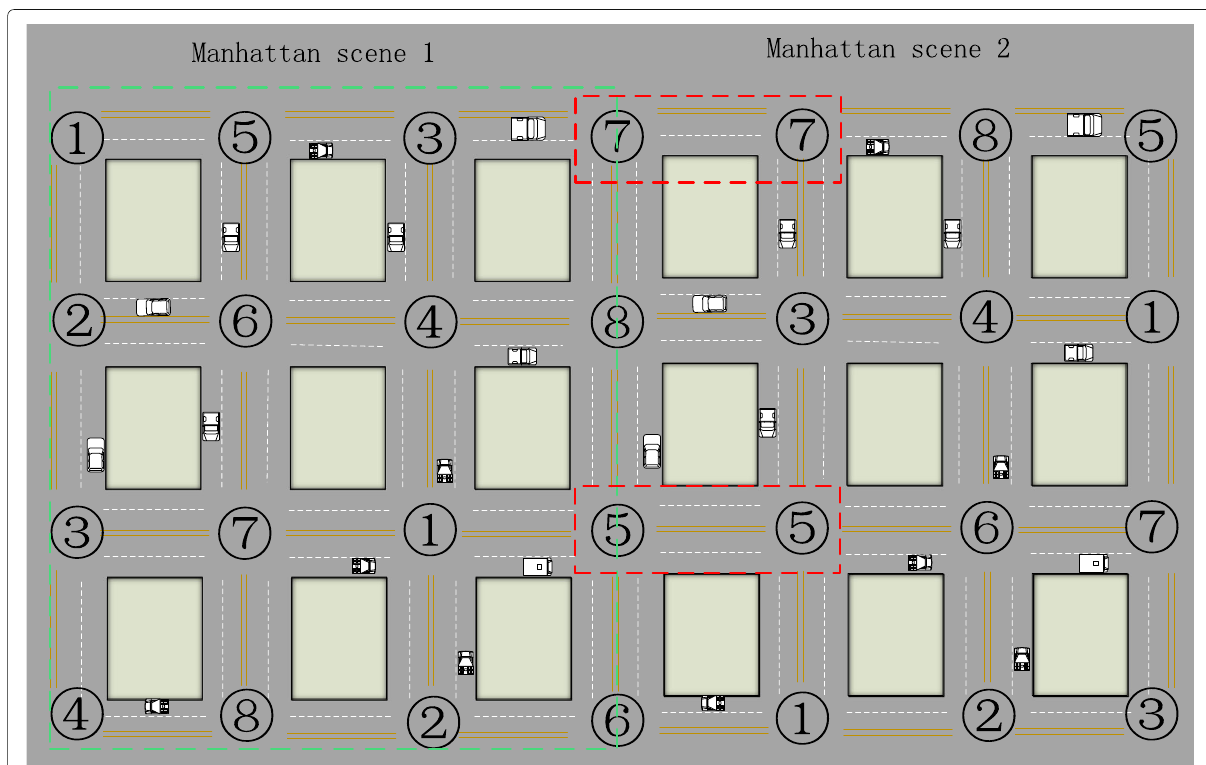
Fig. 8 System model for several urban scenes. Description of the problem of boundary interference when there are several urban scenes. Each number in this figure represents the label of the corresponding sub resource pool of a geographic area. Boundary interference exists in the geographic areas with red